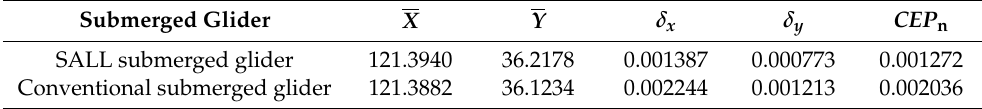
Table 13. The CEP n of the SALL submerged glider and the conventional submerged